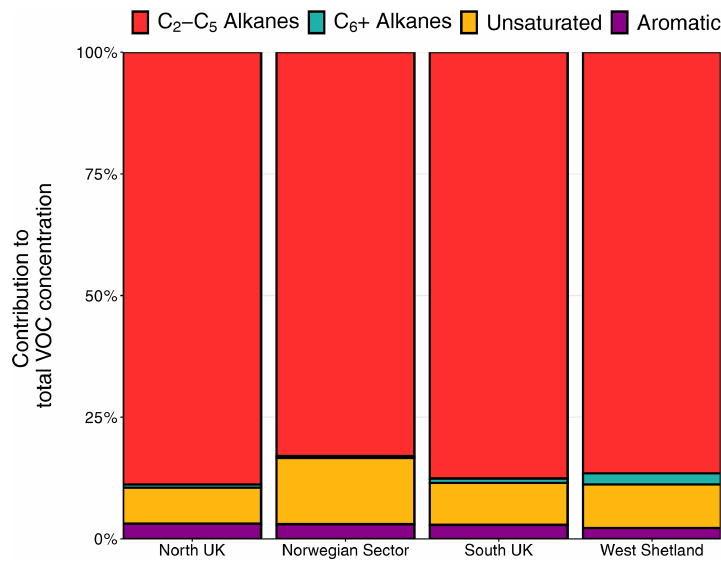
Figure A2. Percentage contribution of each VOC group to total VOC concentrations in each region of the North